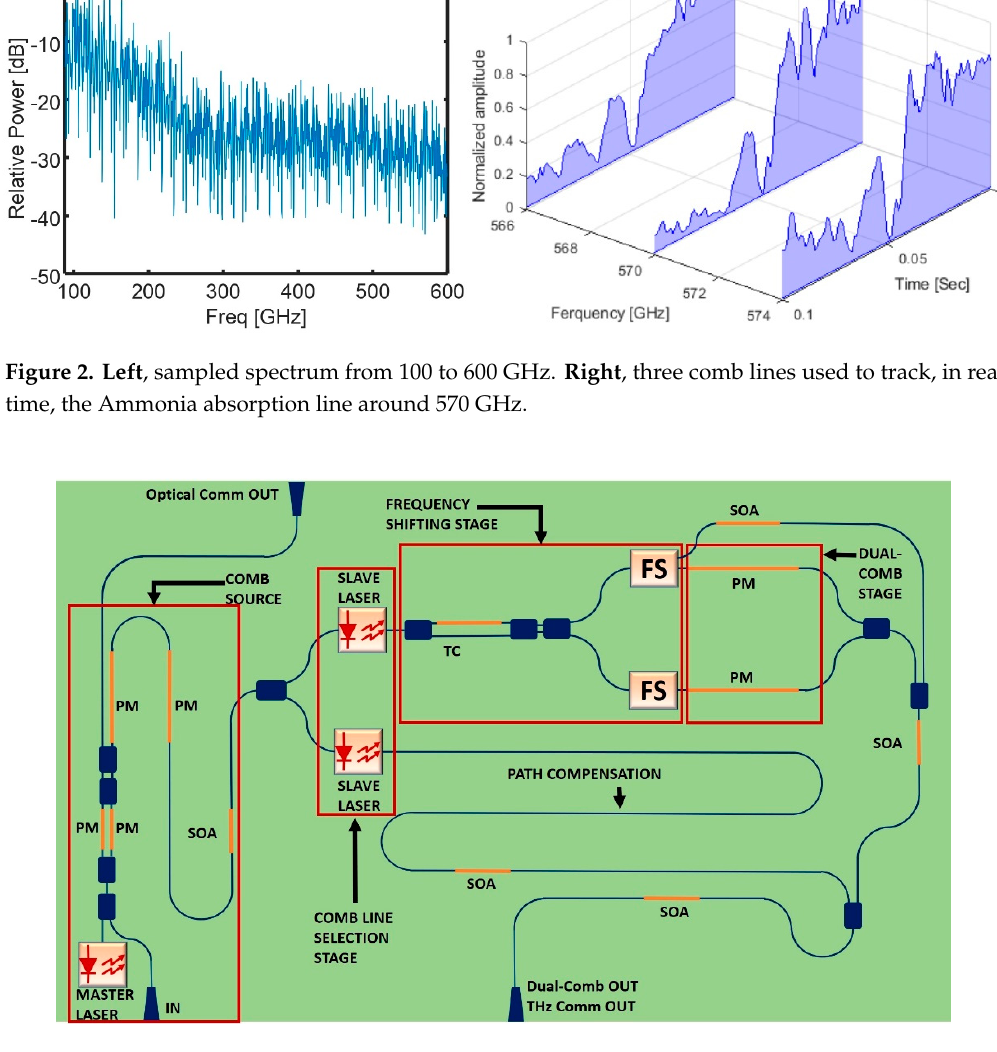
Figure 3. Integrated TDCS. PM: Phase modulator. SOA: Semiconductor optical amplifier. TC: Tunable coupler. PM: Phase modulator. FS: Frequency shifter. The operation is analogous to the benchtop